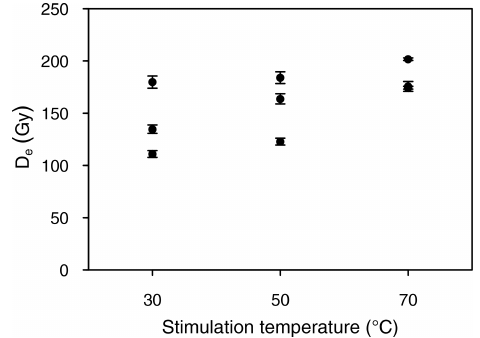
Figure 6. D e determination of the natural signal using different stimulation temperatures for each three aliquots of RIN2